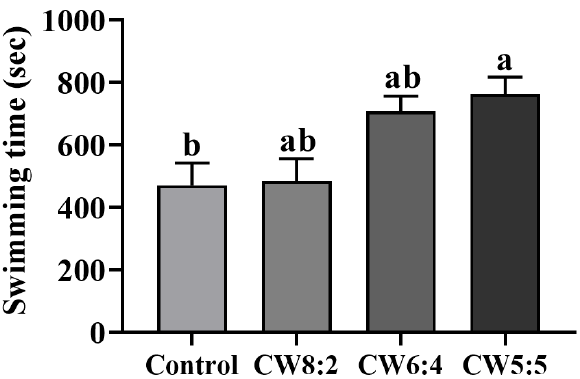
Figure 4. Swimming time of the rats administered milk with adjusted casein to whey proteins ratios for eight weeks ( n = 6). Data are expressed as mean ± SEM. The values with different letters indicate significant differences at p < 0.05. CW, casein: whey proteins.